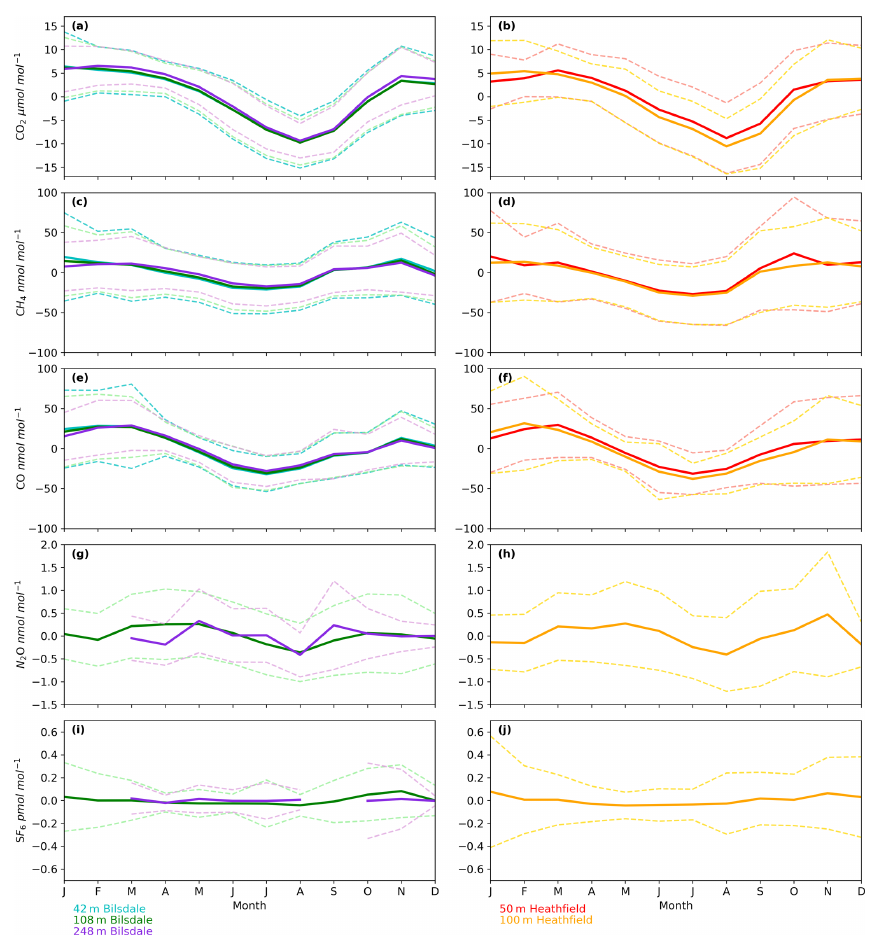
Figure 7. Mean seasonal cycle of detrended hourly mean values for (a, b) CO 2 , (c, d) CH 4 , (e, f) CO, (g, h) N 2 O and (i, j) SF 6 of the Bilsdale 42m (blue), 108m (green) and 248m (purple) and Heathfield 50m (red) and 100m (yellow) intake heights. Dashed lines are the standard